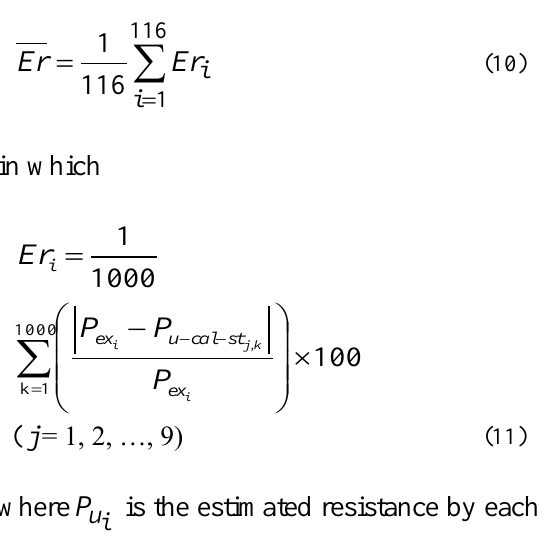
Fig. 6. Cumulative distribution function of the ratio (based on 1000 simulations for each of 116